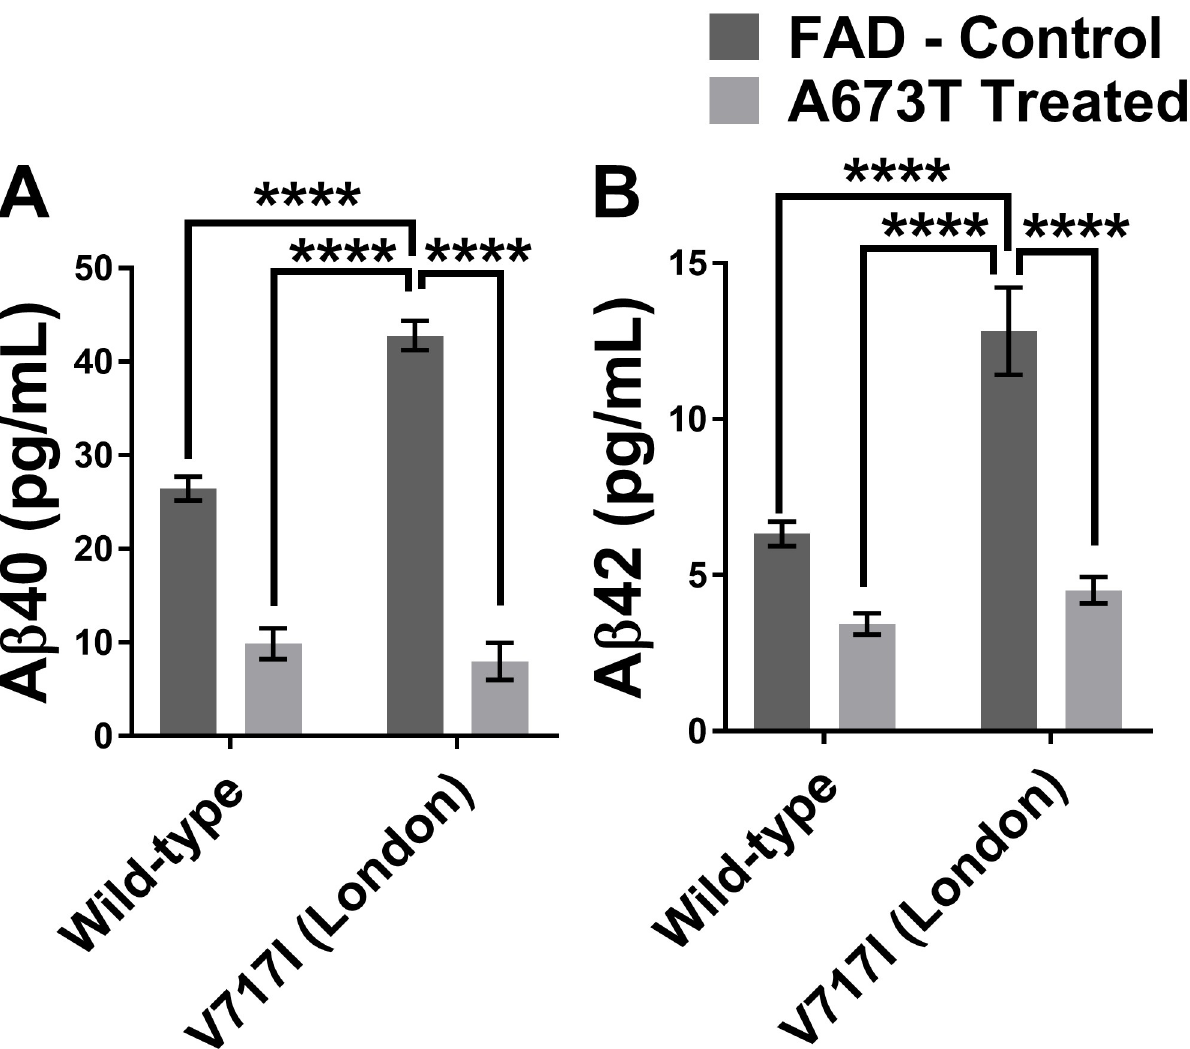
Fig 6. A β peptide concentrations with wild type or London APP gene with or without A673T mutation. A β 40 (in A ) and A β 42 (in B ) concentrations for neuroblastomas transfected with plasmids coding either for a wild type APP gene or an APP gene with the London mutation (V717I) with and without the Icelandic (A673T) mutation. Statistic test: Two-way ANOVA Sidak’s multiple comparison test (n = 6). P value style � p < 0.0332, �� p < 0.0021, ��� p < 0.0002, ���� p < 0.0001.